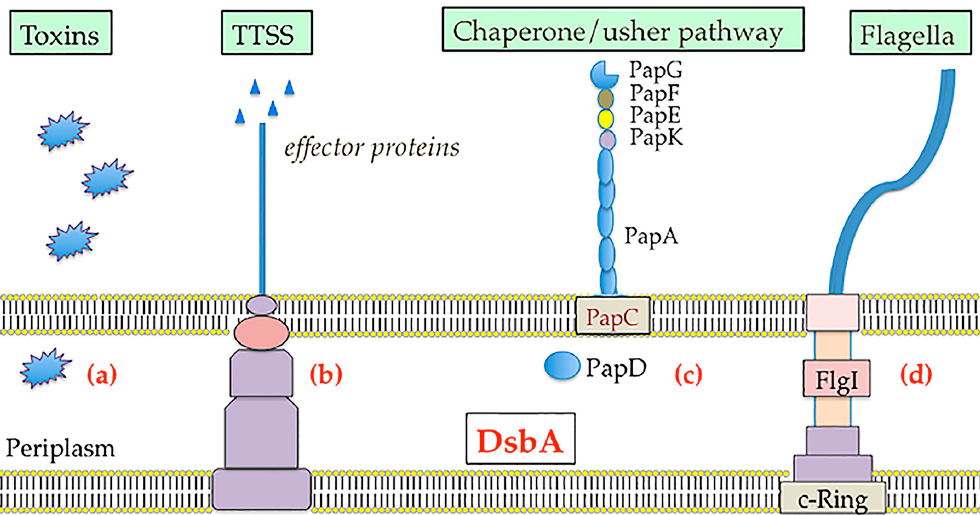
Figure 3. Overview of selected DsbA dependent virulence factors: ( a ) secretion of toxins; ( b ) assembly of the type III secretion system (TTSS); ( c ) folding of different components of the usher chaperon system for fimbriae biosynthesis (e.g., P fimbriae); ( d ) assembly of the flagellar motor (FlgI). Detailed description of the virulence mechanisms dependent on the DsbA/DsbB system can be found in other reviews [14,17].